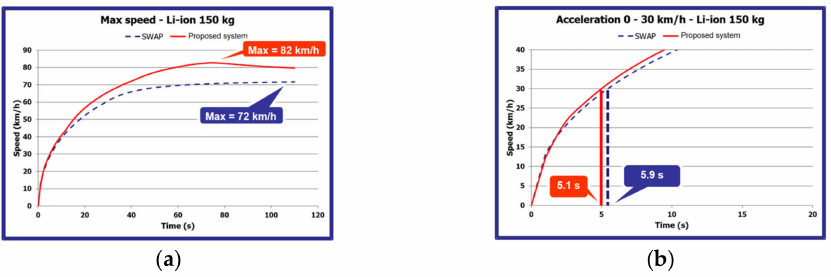
Figure 21. ( a ) Maximum vehicle speed; ( b ) acceleration from 0 to 30 km/h.